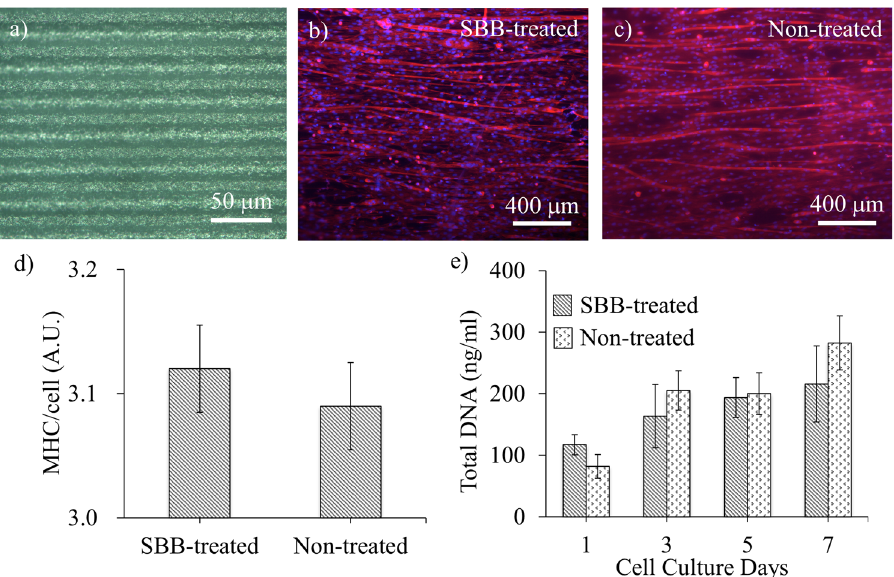
Figure 6. The effect of pre-culture SBB treatment on myogenic differentiation and cell proliferation for C2C12s. ( a ) The micrograph of a microgrooved PCL substrate with the period of 30 μ m. ( b and c ) The fluorescence micrographs of SBB-treated and non-treated microgrooved PCL substrates after 7 days following the addition of the differentiation medium. The microgrooves were laid horizontally. ( d ) Comparison of the degree of myogenic differentiation with and without pre-culture SBB treatment. The degree of myogenic differentiation was determined by the expression of MHC (myosin heavy chain) per cell. ( e ) Cell proliferation was represented by the DNA amount of C2C12 cells cultured on the planar PCL slabs in the growth medium (for up to 7 days). On each day, there was no statistical difference in the total DNA amount between SBB-treated and non- treated groups. For ( b , c ), the myotubes were stained by rhodamine-phalloidin and DAPI on Day 7 following differentiation. Red denotes F-actins; and blue denotes